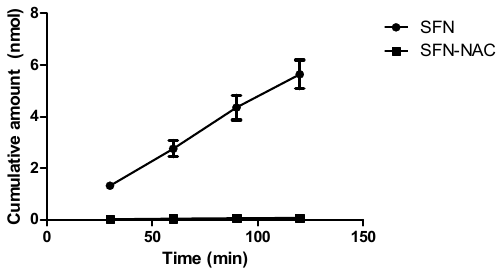
Figure 7. Cumulative amount of SFN and SFN-NAC transported across Caco-2 cell monolayers over time. Data values are expressed as the mean ± standard deviation ( n = 3 at each point). SFN, sul- foraphane; SFN-NAC, sulforaphane N -acetylcysteine.